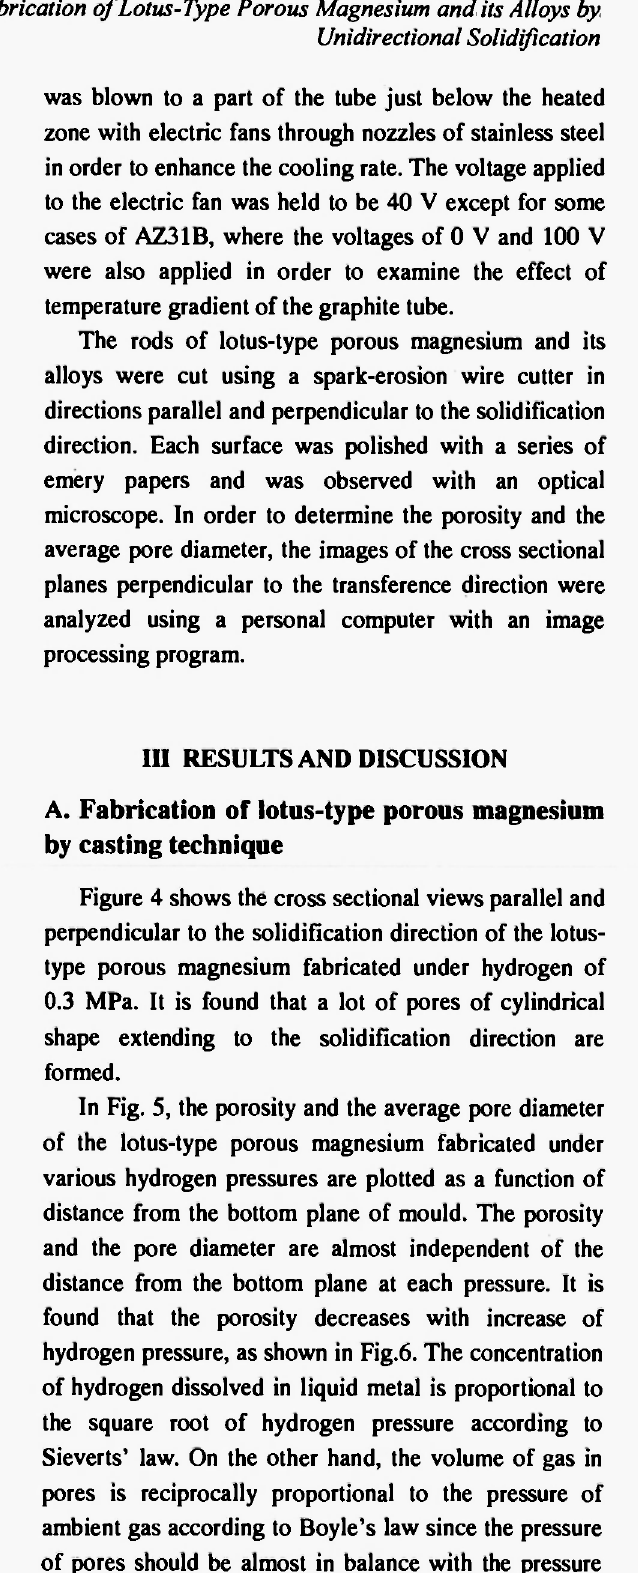
Fig. 3: Schematic drawing of the heating zone of the apparatus used for fabricating lotus-type porous magnesium alloys by continuous zone melting